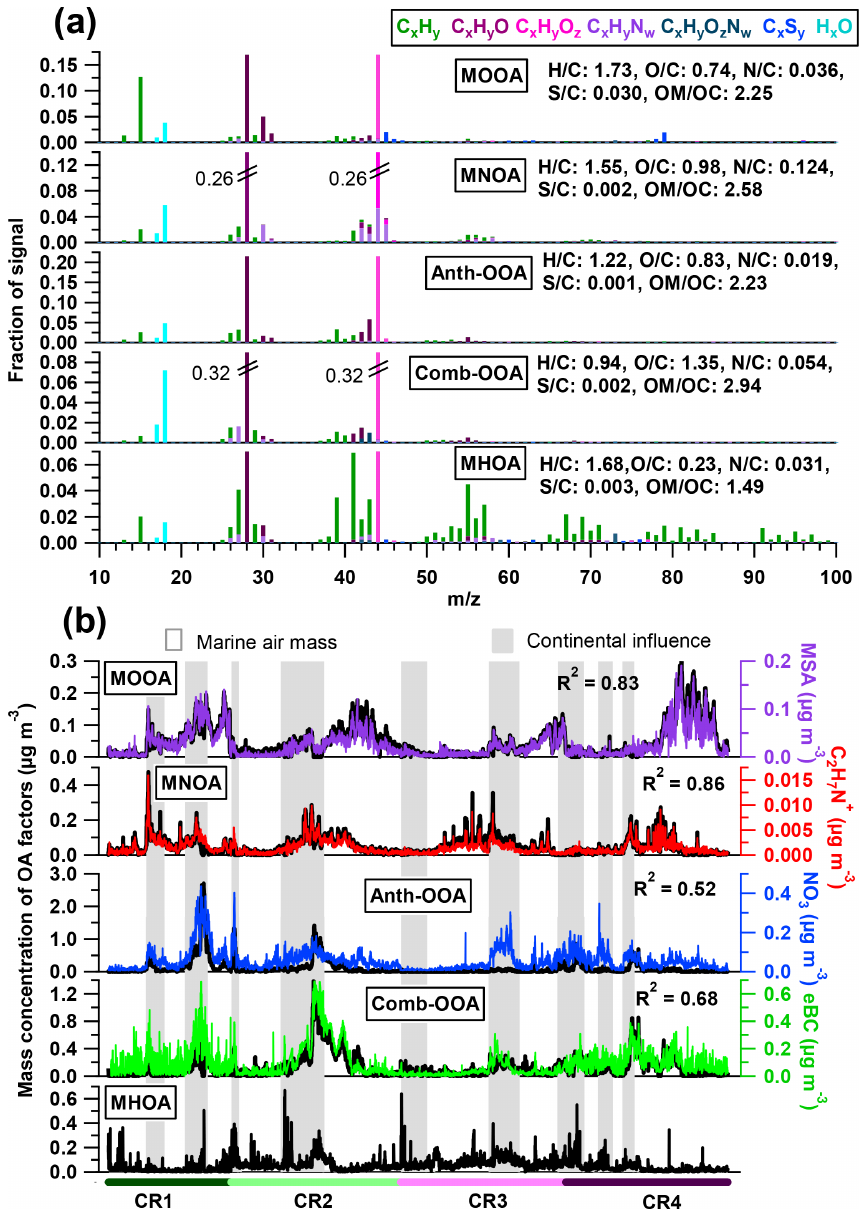
Figure 3. (a) High-resolution mass spectra and (b) time series of five OA components. Also shown are simultaneous variations of tracer compounds on the right axes. Air masses with continental influence (grey) and originating from the ocean (blank) are marked in the back-